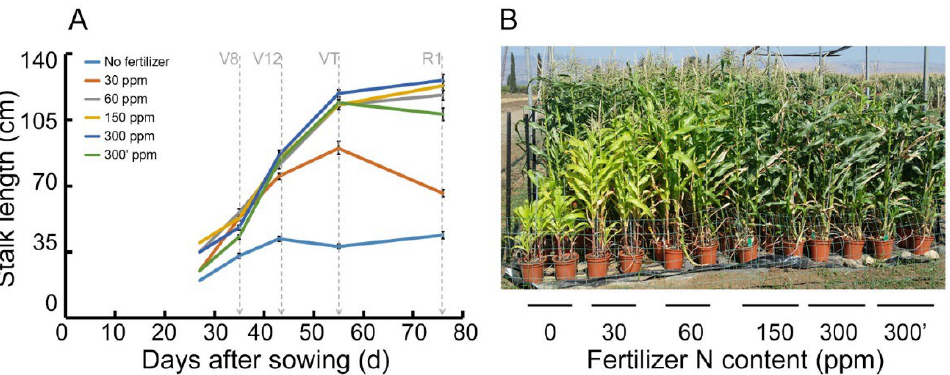
Figure 1. Z. mays (‘Super sweet’, sh2) elongation during 90 days after sowing. ( A ) Elongation length measured from the bottom of the stalk to the last leaf base. The six fertilization treatments were ‘no fertilizer’, 30, 60, 150, 300, 300 (cid:48) ppm N, and are colored in light blue, orange, grey, yellow, blue, and green, respectively. n = 5, error bars represent standard error of the mean. Vertical dashed light grey arrows represent the data acquisition occasions, where V8, V12, VT and R1 symbolize stages as follows: 8th leaf emergence, 12th leaf emergence, tasseling stage, and corn cob development, respectively. ( B ) RGB picture of the original experimental design as was performed in: ”Novel Remote Sensing Index of Electron Transport Rate Predicts Primary Production and Crop Health in L. sativa and Z. mays“. Available online: https://www.mdpi.com/2072-4292/12/11/1718/htm [7] (accessed on 1 January 2022). Only the first row out of five is clearly visible in the figure. The picture shows a snapshot of the corn growth on the background of the fertilization treatments. The picture was taken during the VT stage and the fertilization gradient treatments are organized from left to right 0–300’ ppm N.